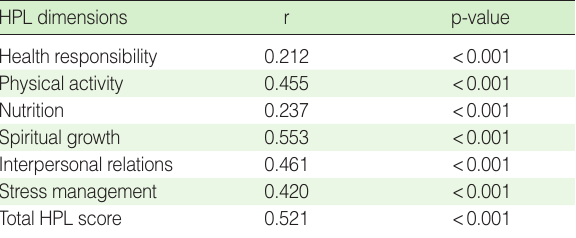
Table 3. Pearson correlations between health-promoting lifestyle (HPL) dimensions and quality of life